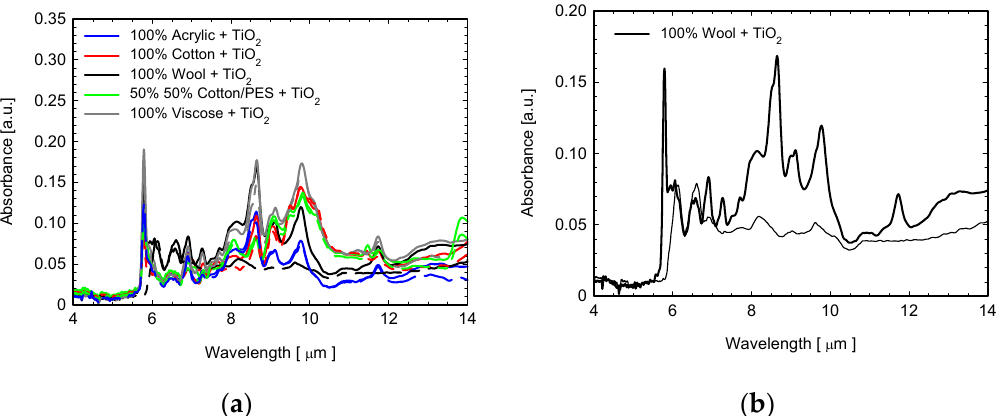
Figure 9. ( a ) ATR ‐ FTIR spectra of investigated fabrics coated with TiO 2 (solid lines) and uncoated (dashed lines) in the range 4–14 μ m; ( b ) detailed comparison between coated (solid line) and uncoated (dotted line) wool fabrics.